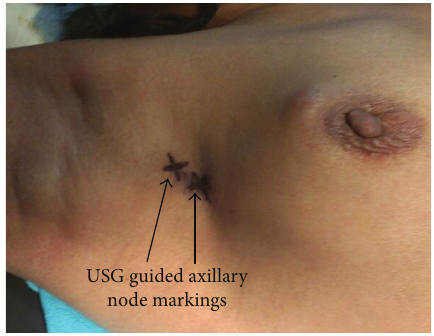
Figure 1: Marking of the suspicious nodes.